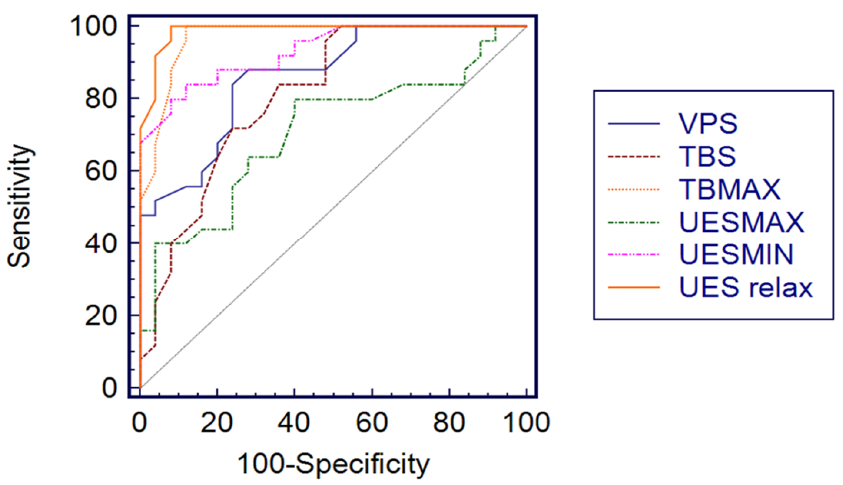
Figure 2. The threshold values of significant HRM parameters for identifying inhalation risk in